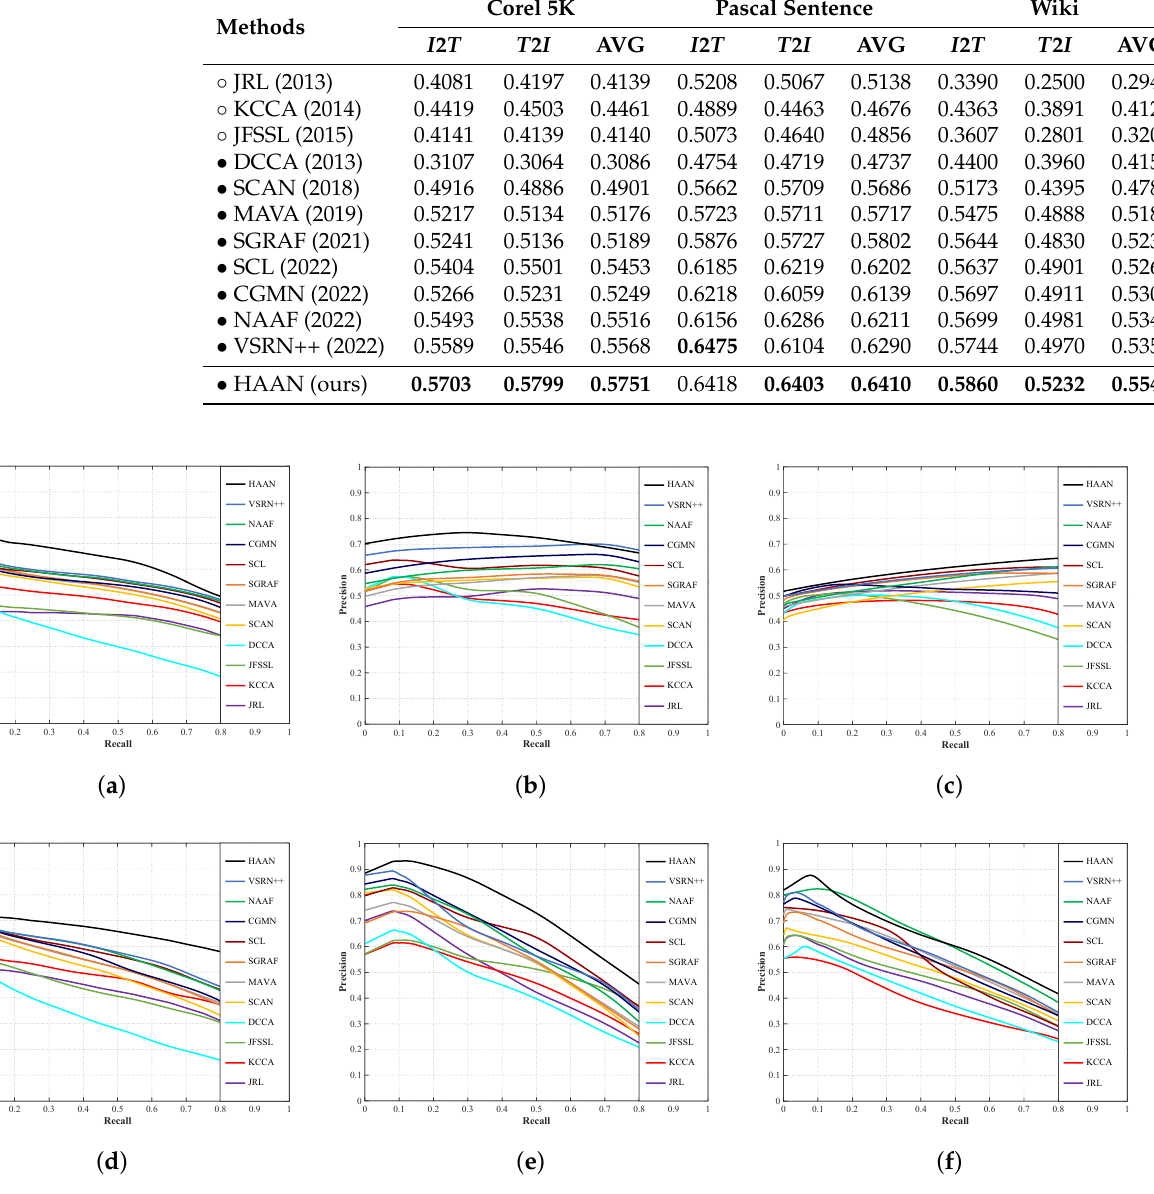
Figure 5. The PR curves of image-text retrieval for HAAN and other compared methods on all datasets. ( a ) I 2 T on Corel 5K; ( b ) I 2 T on Pascal Sentence; ( c ) I 2 T on Wiki; ( d ) T 2 I on Corel 5K; ( e ) T 2 I on Pascal Sentence; ( f ) T 2 I on